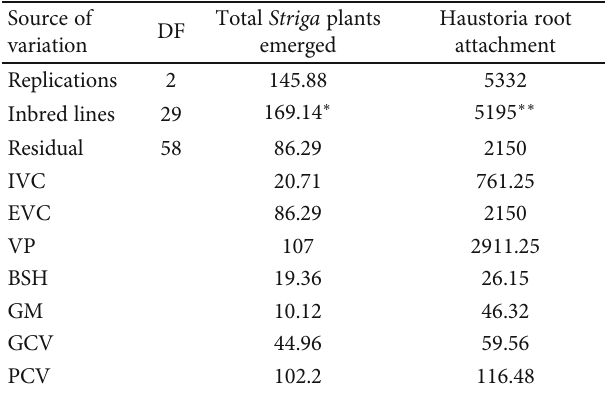
Table 4: Mean squares for total Striga plants emerged and haustoria root attachment.